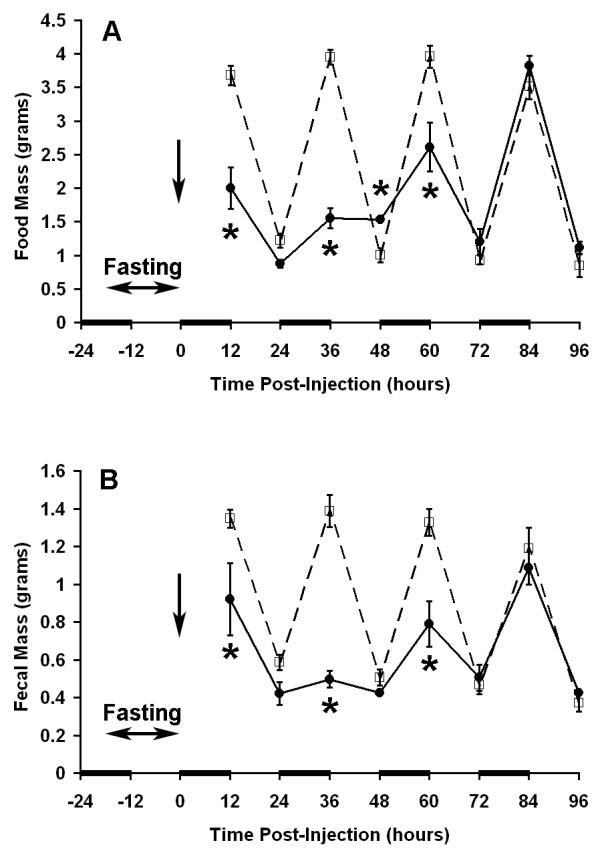
Effect of cerulein induced acute pancreatitis on food intake and fecal output. Twelve hour measurements were plotted as described in legend for Figure 2. Seven hourly injections of cerulein (50 μg/kg per dose) were administered after a 12-hour fasting period ending at time 0 (solid line) and compared to control mice receiving carrier alone (dotted line). N = 6 mice per group. * P = 0.009 vs. control at corresponding time point.